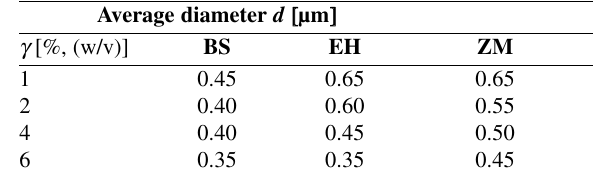
Table 2. Average diameter of BS, EH, and ZM levan particles at 1, 2, 4, and 6 % (w/v) concentrations. Error estimate for average dia- meter is ± 0.10 μm.